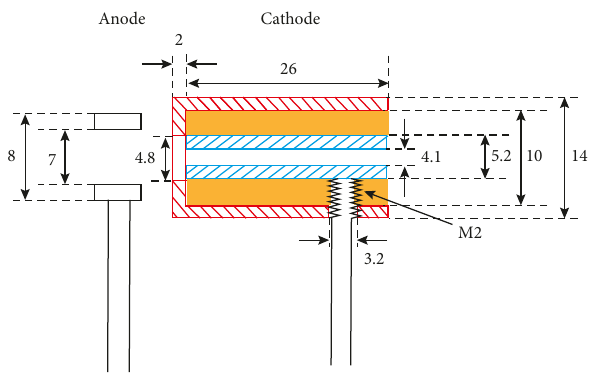
Figure 2: Schematic of the electrode system (sizes in